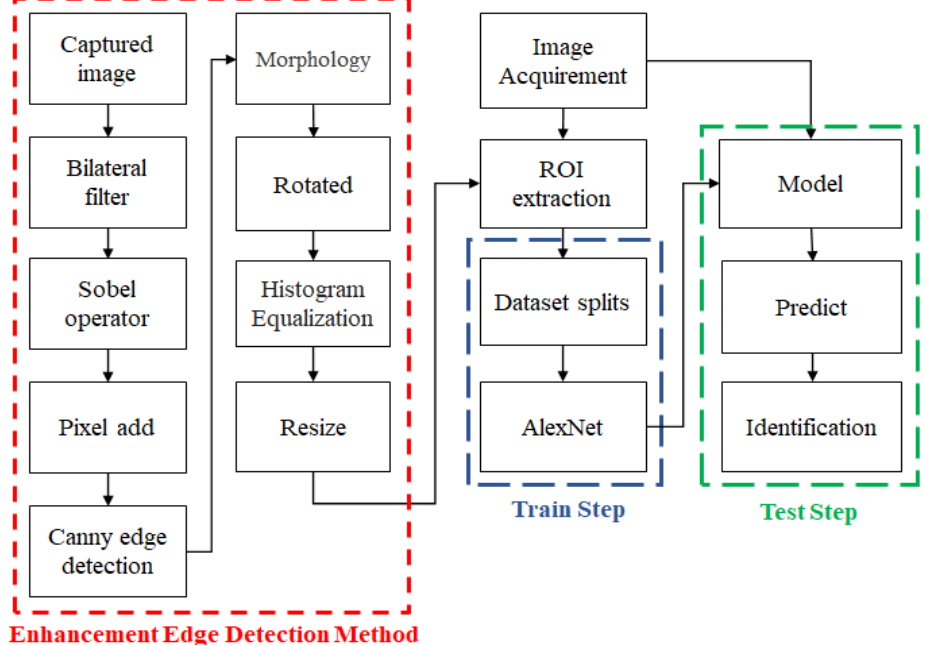
Figure 1. Flowchart for the proposed system.